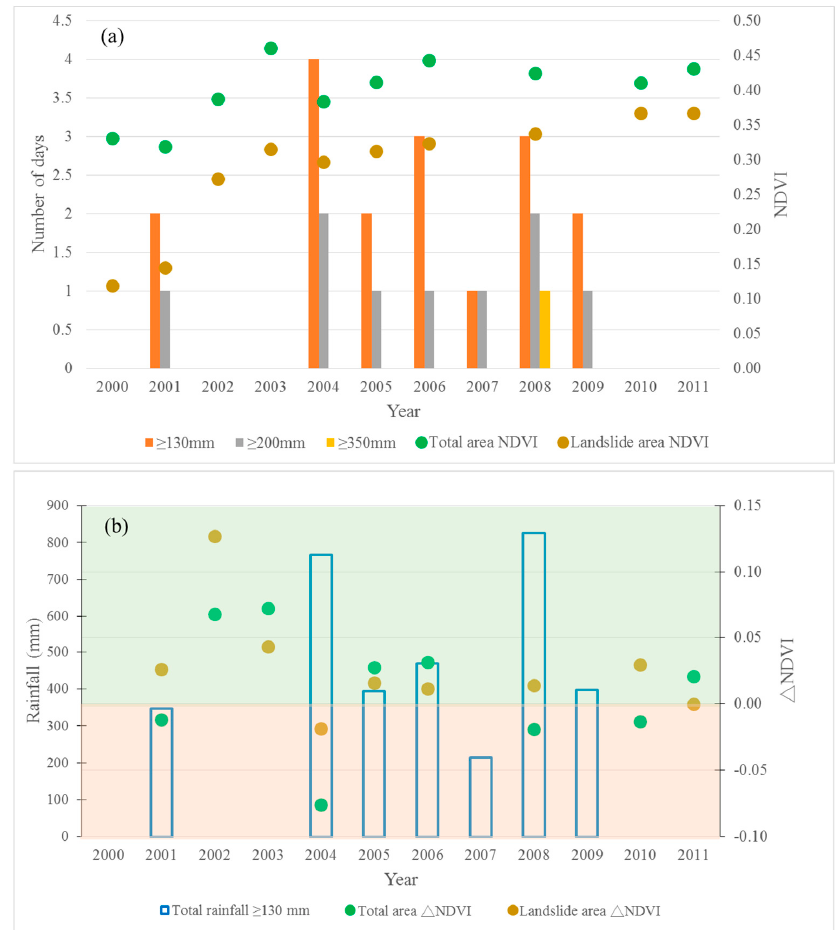
Figure 9. NDVI and Δ NDVI values varying with ( a ) number of days with precipitation over rainfall warning thresholds and ( b ) yearly total of 24-h rainfall exceeding 130 mm.